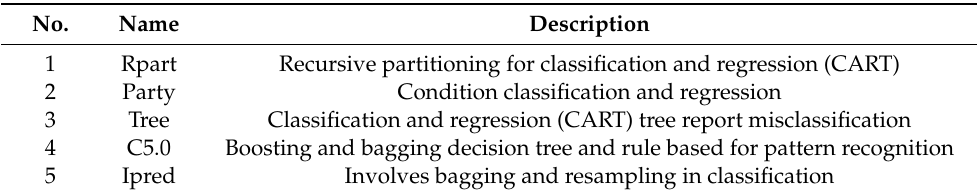
Table 3. Description of DT algorithms used in the study.